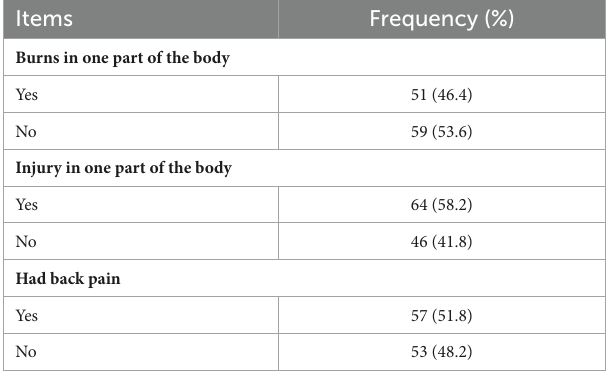
TABLE 4 Direct health issues from biomass collection and burning.